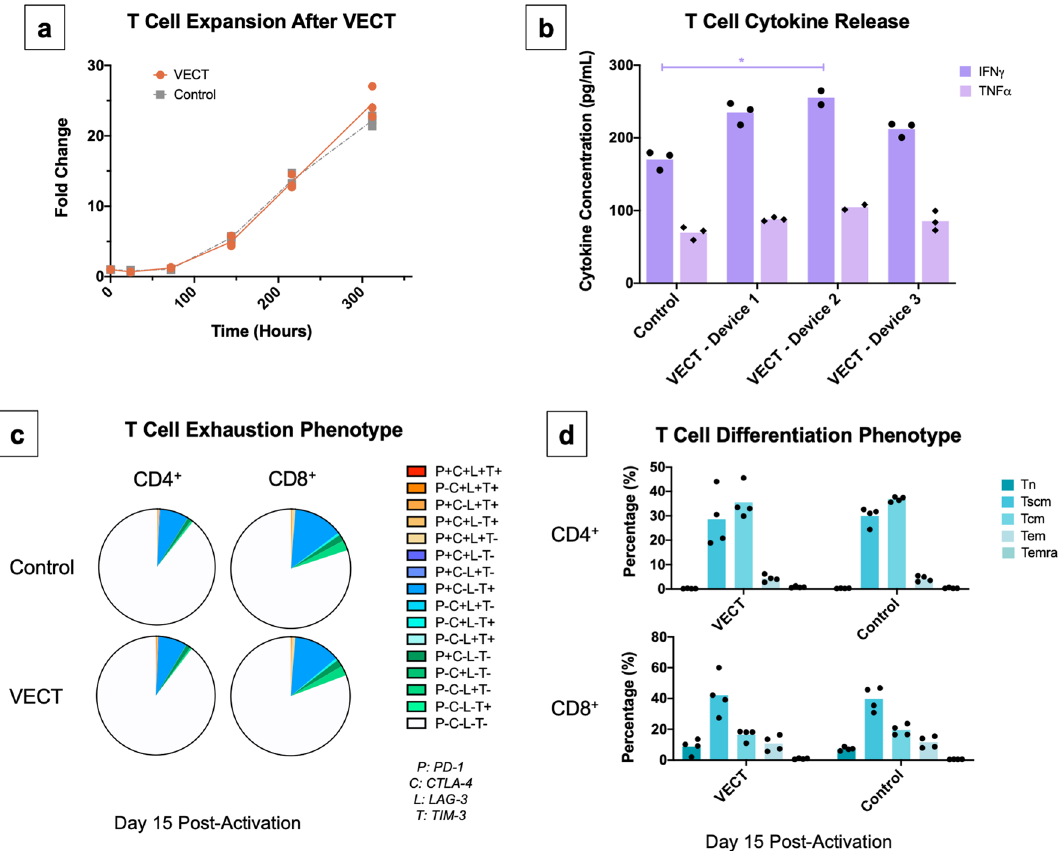
Figure 3. Cell functionality is preserved upon VECT. ( a ) Fold change in T cell expansion after VECT transfection closely followed the expansion seen in negative control cells (n = 3). ( b ) IFNγ and TNFα secretion was measured in cells re-activated 24 h after transfection, and results showed comparable expression between supernatant collected from a control cell sample and supernatants collected from three VECT-transfected samples (n = 3). Statistical analysis for IFNγ and TNFα secretion showed one significant difference in secretion levels of IFNγ between control cells and device 2 cell sample (Kruskal–Wallis test, p = 0.0036; Dunn’s multiple comparisons test, p = 0.0247); ( c ) exhaustion profiles in expanded CD4 + and CD8 + T cell populations of both VECT and negative control cells, as measured by the detection of four exhaustion markers (PD-1, CTLA-4, LAG-3 and TIM-3) (n = 3). Results did not show evidence of exacerbated exhaustion after undergoing VECT, compared to the negative control. ( d ) T cell differentiation phenotype distribution was comparable between VECT and control cells for both CD4 + and CD8 + cells (n = 4). T cell subsets were measured as follows: Naïve (Tn: CD45RA + , CD45RO − , CD62L + , CD95 − ), Stem Cell Memory (Tscm: CD45RA +− , CD45RO − , CD62L + , CD95 + ), Central Memory (Tcm: CD45RA − , CD45RO + , CD62L + , CD95 + ), Effector Memory (Tem: CD45RA − , CD45RO + , CD62L − , CD95 + ), Effector Memory CD45RA + (Temra: CD45RA + , CD45RO − , CD62L − , CD95 + ). T cells that could not be assigned to specific differentiation subsets were excluded from this